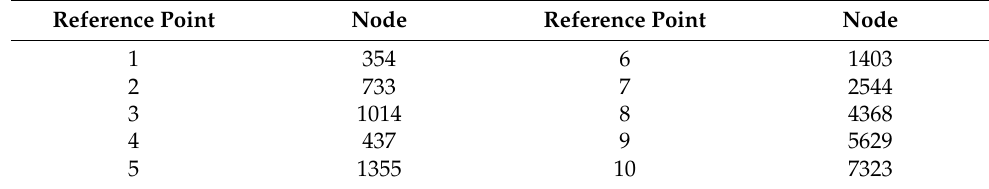
Table 4. Ten reference points corresponding to the nodes.